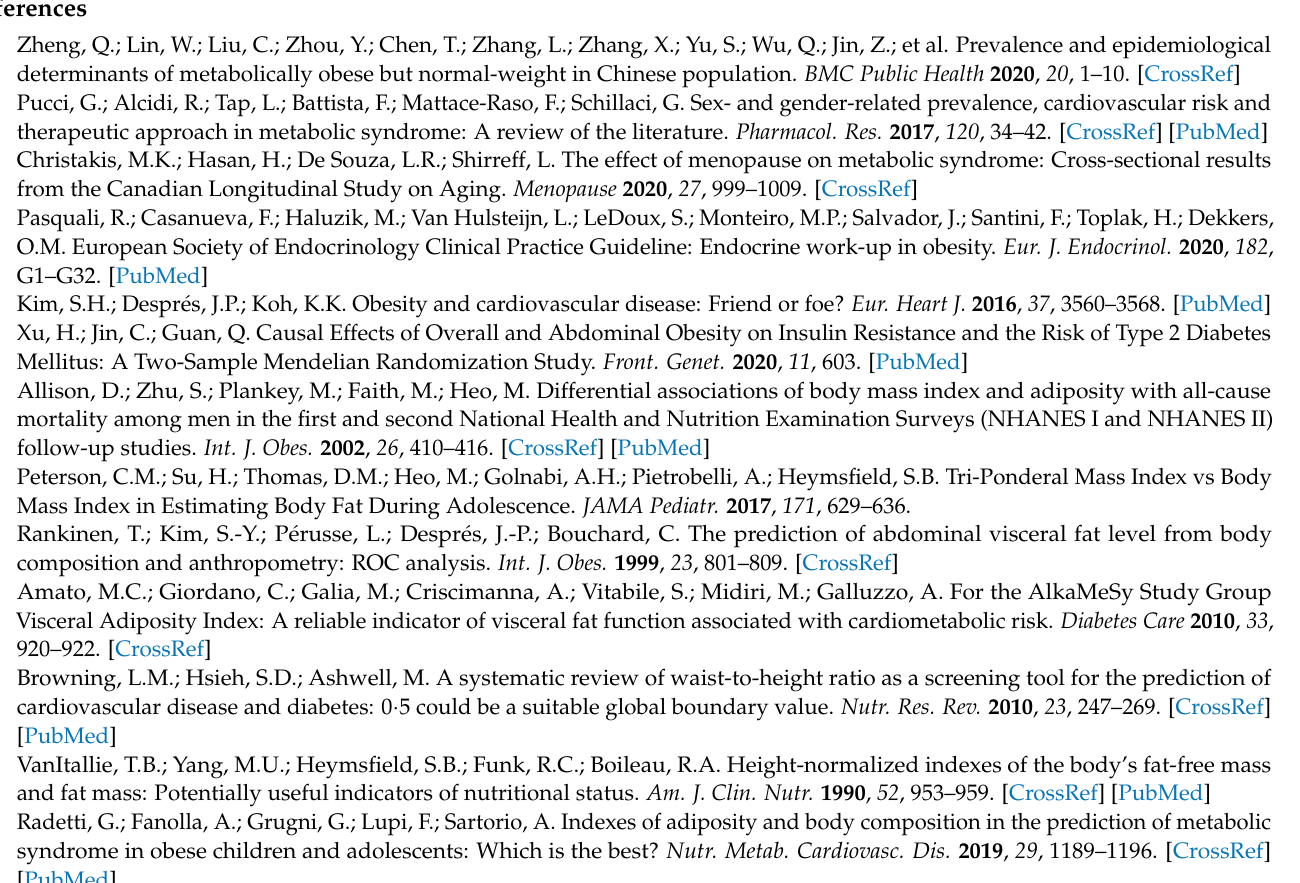
brackets. Table S1: ANOVA and Bonferroni-test for all subjects MetS+, subdivided for age group. Data are presented as mean ± SD. Table S2: Pearson partial (age) correlation analysis between the different indices in all subjects, MetS − and MetS+ subjects. For significance: * p < 0.0001, & p < 0.01, $ p = 0.056. Table S3: Area under ROC curves relating each anthropometric measure to clinical cut point after adjusting for